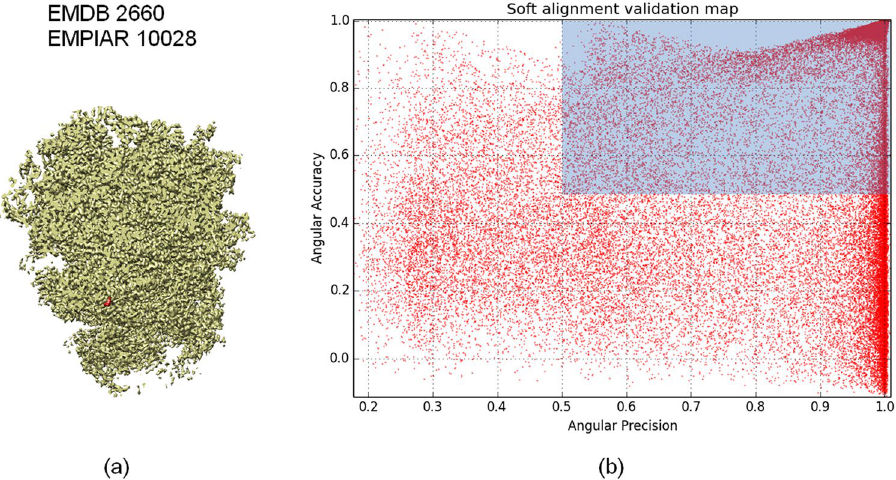
Figure 11. 80S ribosome with EMDB code 2660 and used in the 2015 Map Challenge ( a ) and resultant soft- alignment validation plot ( b ) obtained when 69,402 particles deposited in EMPIAR 10028 were used.